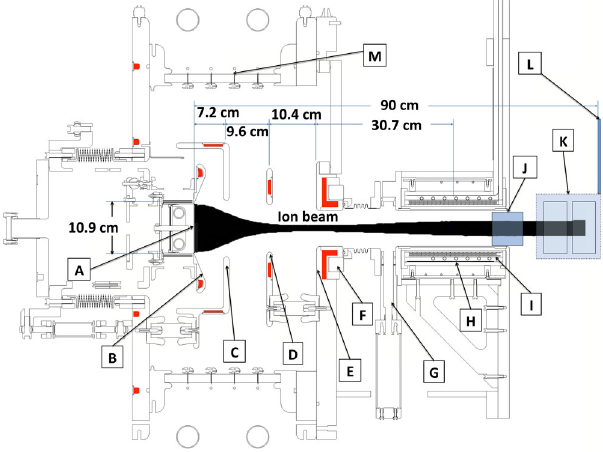
FIG. 2. NDCX-II injector and initial diagnostics. The water- cooling channels are shown in red. Legend: A: emitter; B: Pierce electrode; C: extractor aperture (pulsed); D: accelerating aper- ture; E: ground plate; F: Rogowski coil; G: gate valve; H: corrector coil; I: solenoid; J: electron trap; K: Faraday cup; L: scintillator; M: insulating column.